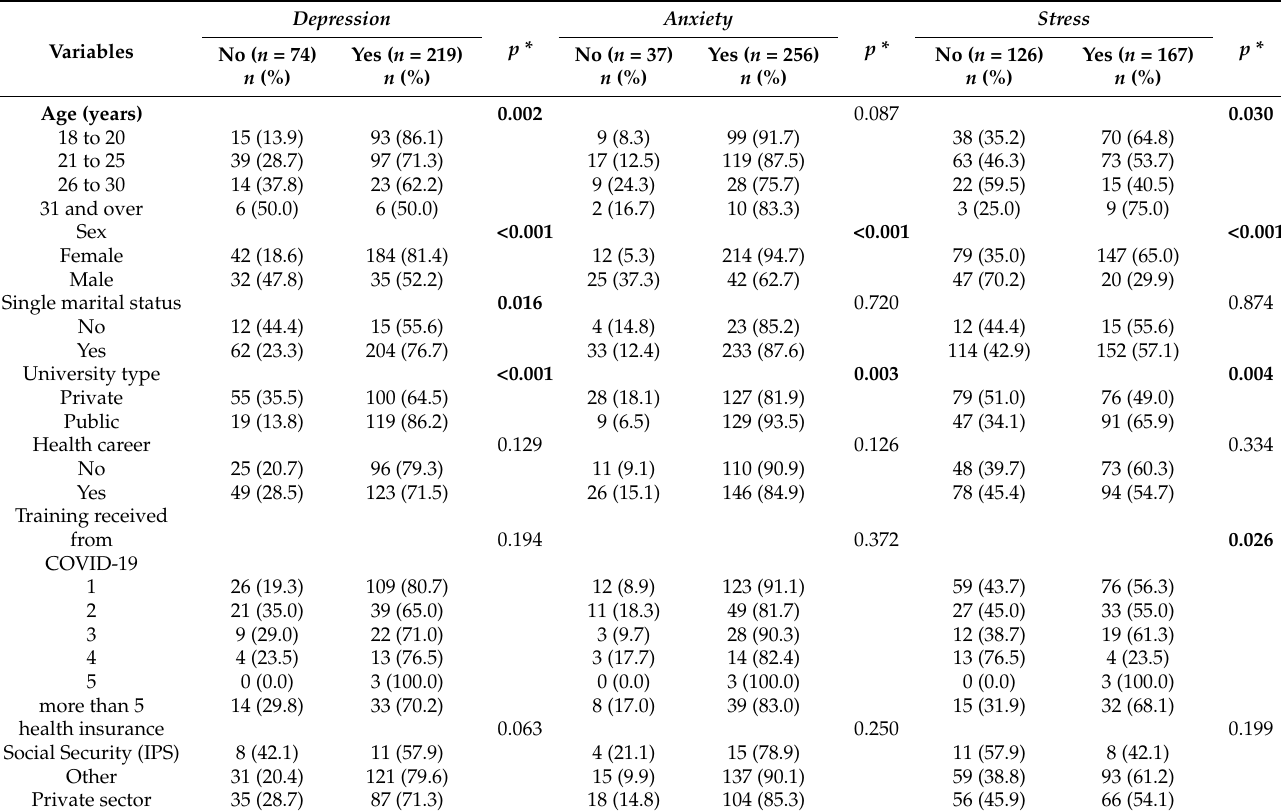
Table 2. Factors associated with depression, anxiety and